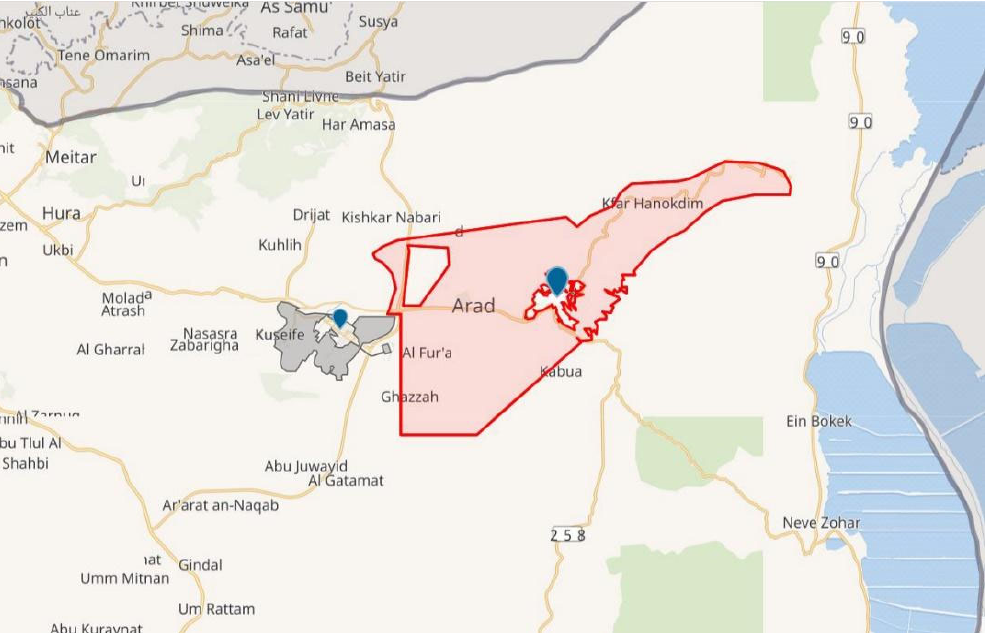
Figure 2. Map of the southern Israeli “Negev” desert region. Marked are the settlement of Al Baqi’a valley and the city of Arad (red) and the Bedouin town of Kuseife (gray). Source: Wikimedia Israel maps, OpenStreetMap ® .